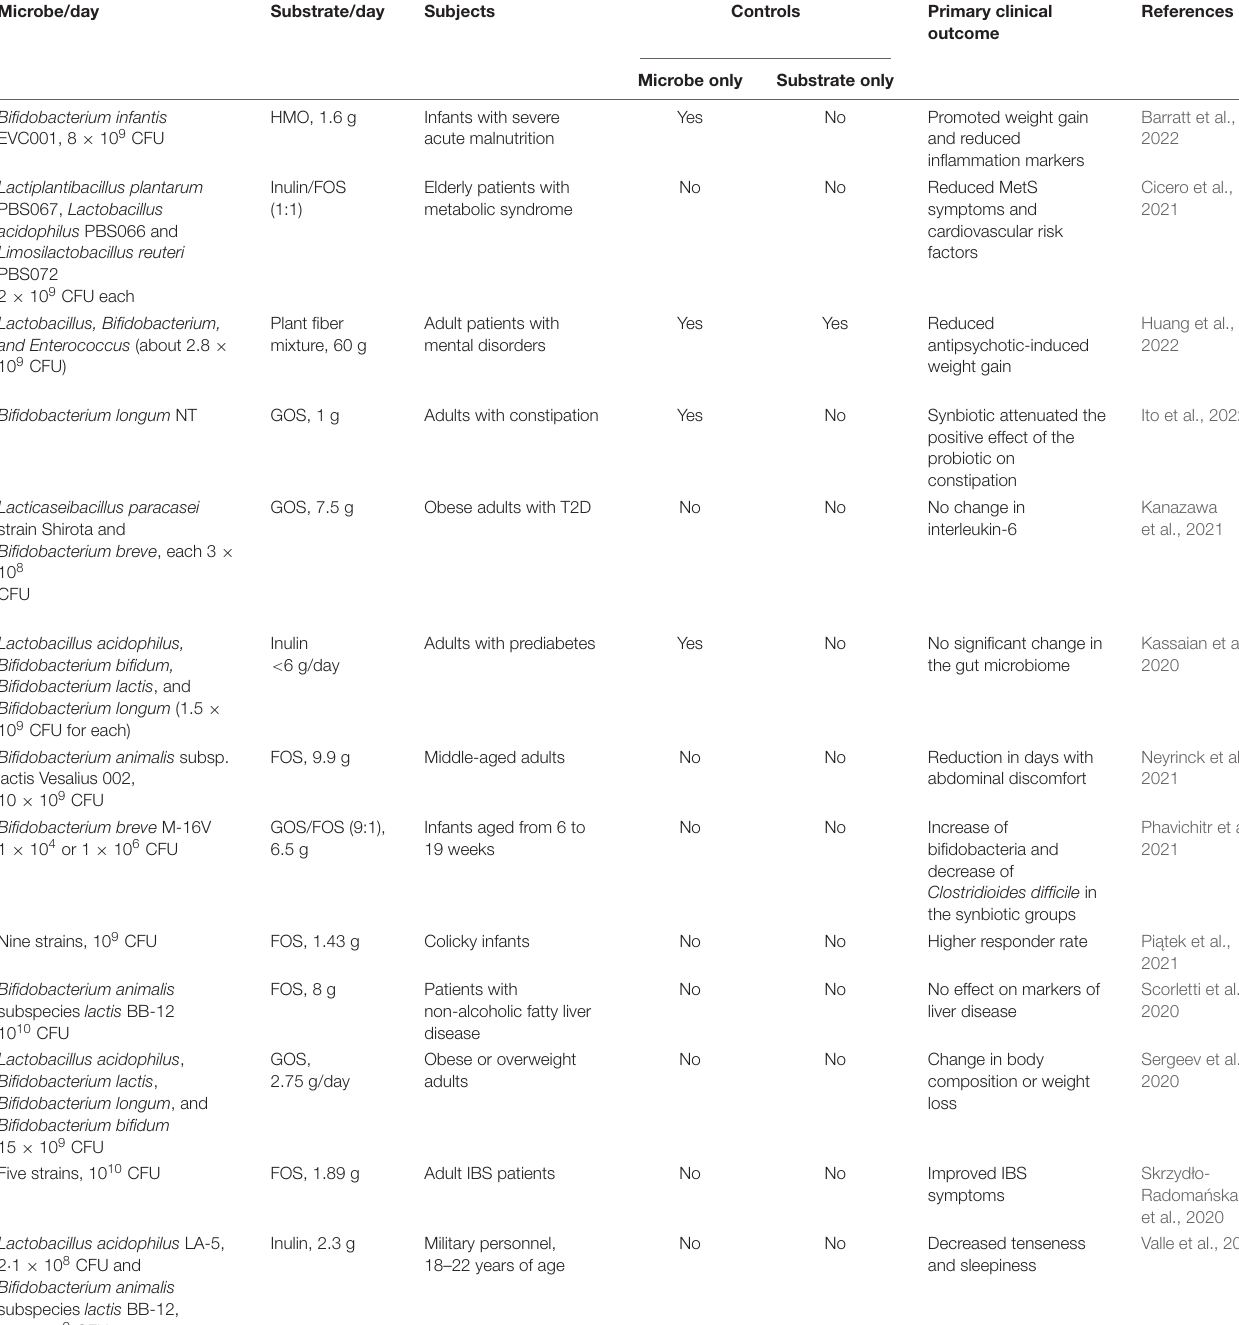
TABLE 1 | Summary of recent (since 2020) synbiotic clinical